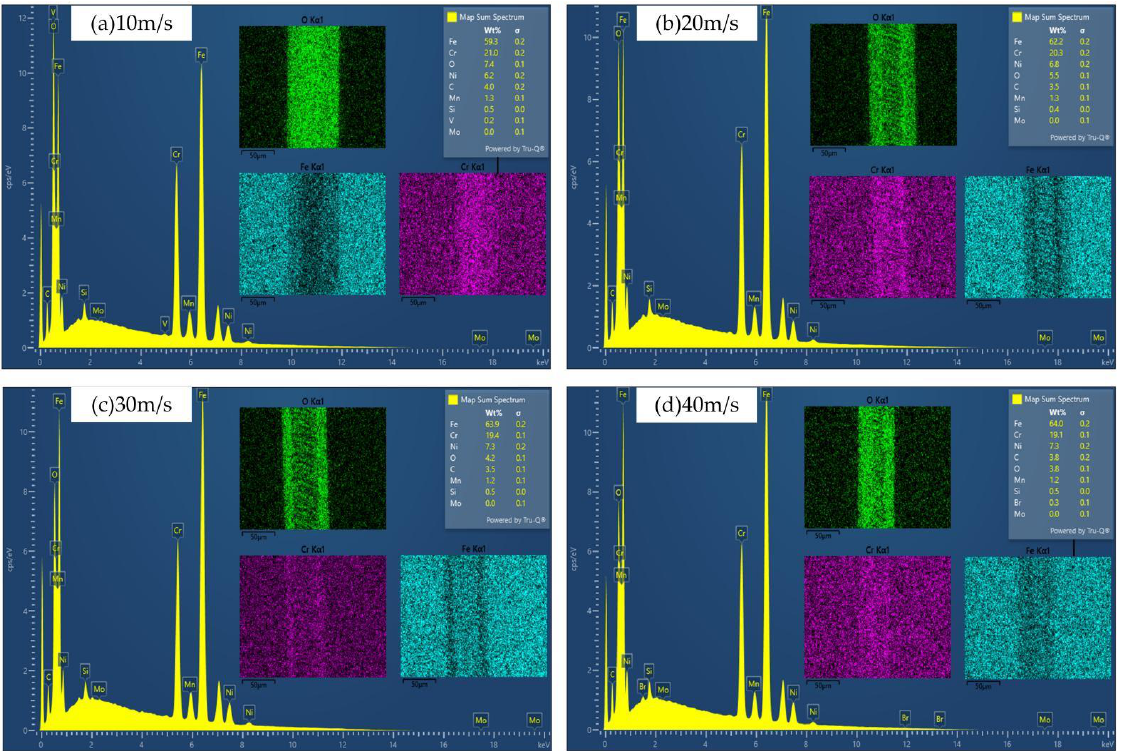
Figure 8. EDS test of remelted layer composition, ( a ) 10 m/s; ( b ) 20 m/s; ( c ) 30 m/s; ( d ) 40 m/s.